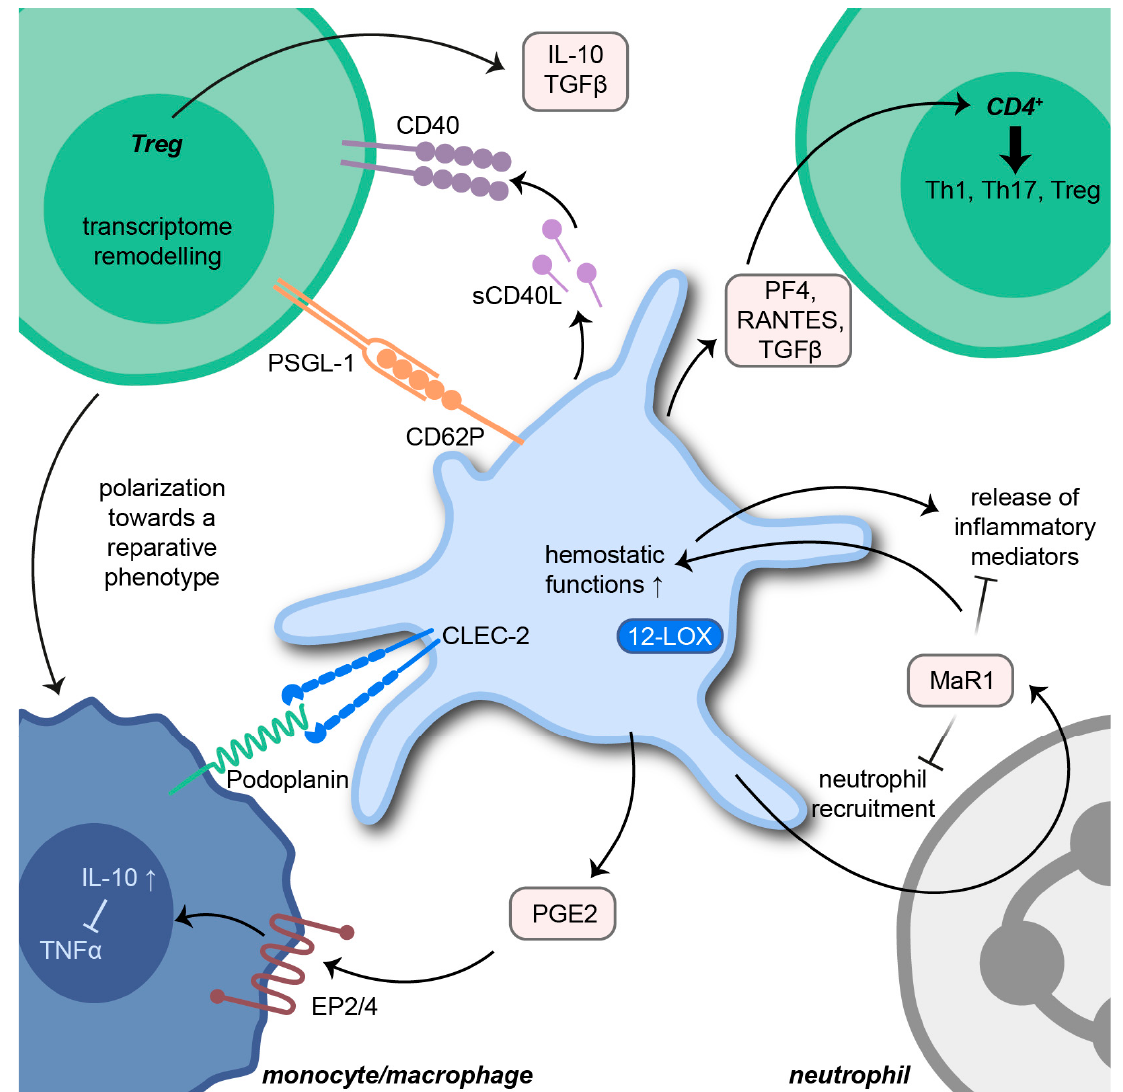
Figure 3. Platelets in inflammatory resolution processes. Interaction of platelets with different im- mune cells results in the production and release of anti-inflammatory mediators, which promote pro-resolving immune processes. Platelet-derived 12-lipoxygenase (12-LOX) initiates the synthesis of maresin 1 (MaR1), a pro-resolving protein inhibiting the release of pro-inflammatory mediators. Prostaglandin E2 (PGE2) increases the production of the anti-inflammatory cytokine interleukin (IL)-10 by monocytes/macrophages and, thereby, prevents the expression of tumor necrosis factor α (TNF α ). Monocyte infiltration is further reduced by platelet C-type lectin receptor 2 (CLEC-2) binding to monocytic podoplanin. Platelet-derived platelet factor 4 (PF4), regulated and normal T cell expressed and secreted (RANTES) and transforming growth factor β (TGF β ) affect the differen- tiation of CD4 + T cells in T helper (Th) and regulatory T cells (Tregs). Interaction with Tregs via sCD40L/CD40 and P-selectin glycoprotein ligand-1 (PSGL-1)/CD62P promotes Treg-dependent po- larization of macrophages toward a reparative fate.